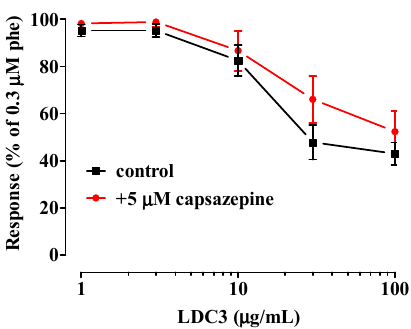
Figure 3. E ff ects of capsazepine on LDC3 -induced relaxation. Endothelium-intact rings, pre-contracted by 0.3 µ M phenylephrine, were challenged with cumulative concentrations of LDC3 , in the absence (control) or presence of 5 µ M capsazepine. In the ordinate scale, relaxation is reported as a percentage of the initial tension induced by phenylephrine (Phe). Data points represent mean ± SEM ( n = 6).